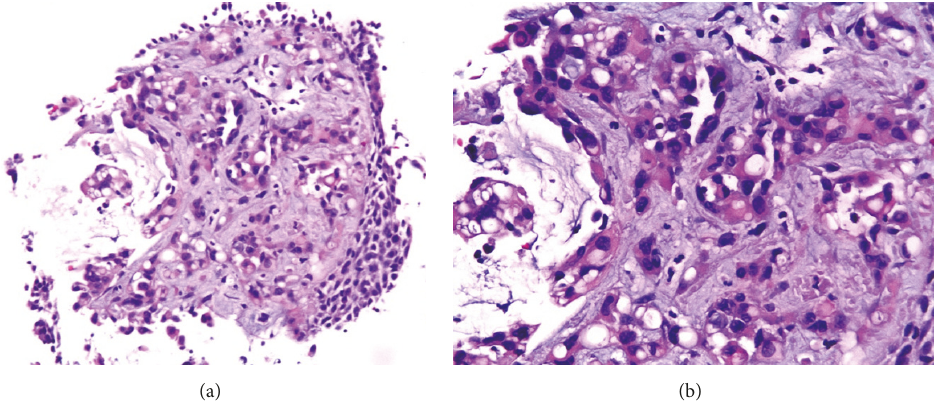
Figure 7: Transbronchial biopsy of a pulmonary mass (H-E). (a) 10x. (b) 20x. Vascular proliferation and endothelial cells, frequently with citoplasmatic vacuolization, in a fibromyxoid stroma, with bronchial surface epithelial